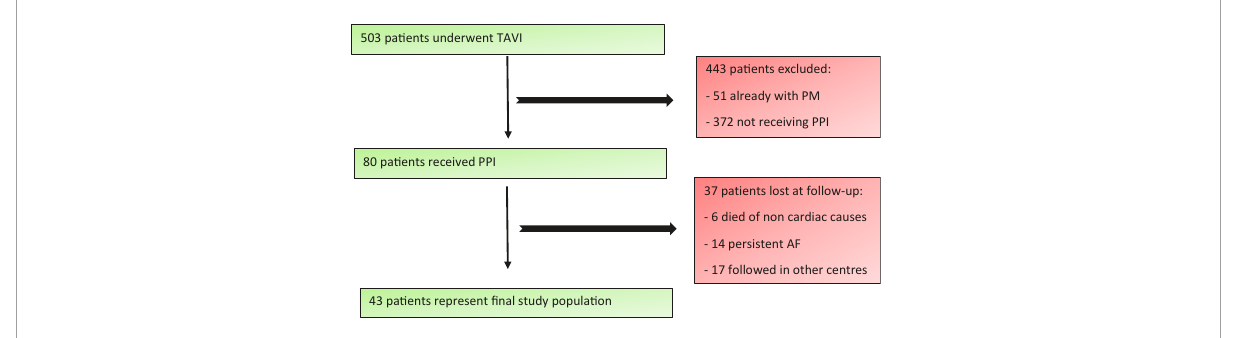
FIGURE1 Study population enrolment criteria. TAVI, Transcatheter Aortic Valve Implantation; PM, pacemaker; PPI, permanent pacemaker implantation; AF, atrial fibrillation.